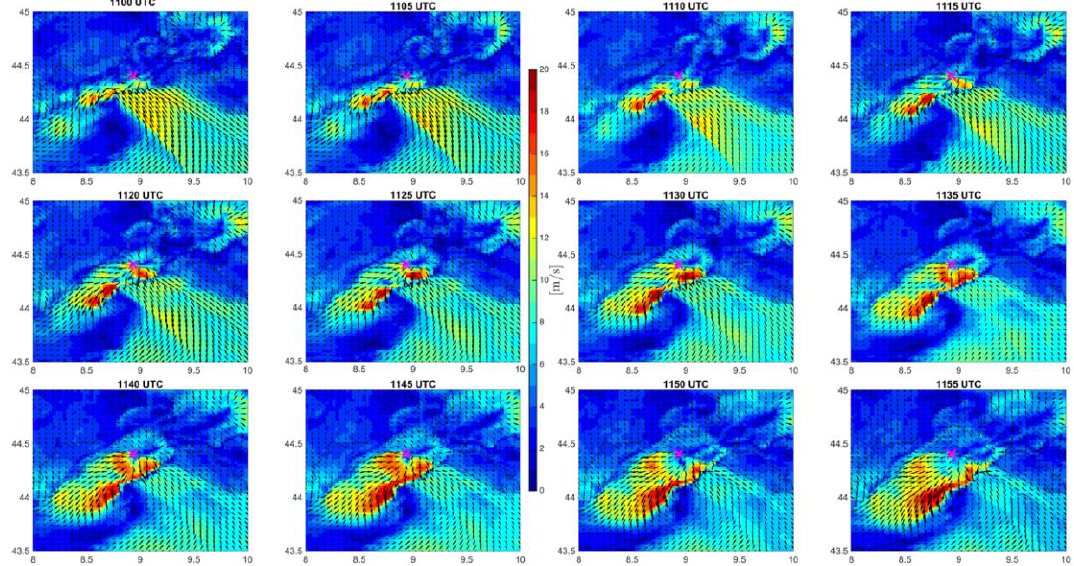
Figure 20. Ten-minute maximum wind speed maps at 5-min temporal resolution for the WRF-IFS-DA experiment (11:00–11:55 UTC). Wind vectors are also shown. The purple cross indicates the former position of the Morandi Bridge.